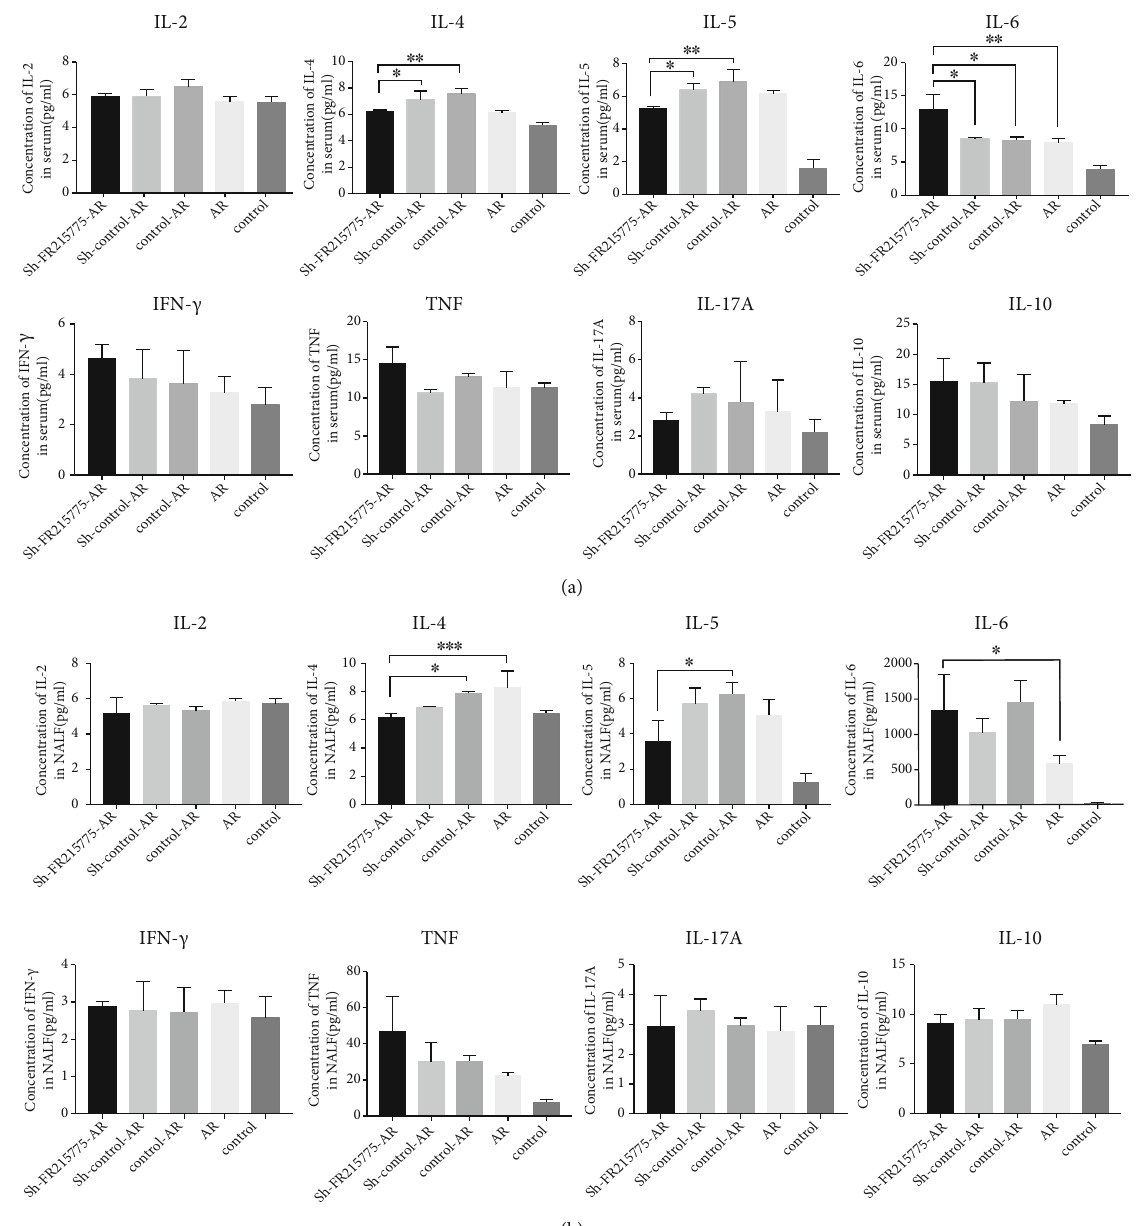
Figure 6: The sh-FR215775-AR group mice showed downregulation of Th2 cytokines. Expression of related cytokines in (a) murine serum and (b) murine NALF. The concentrations of IL-4 and IL-5 in lncRNA FR215775 silencing group were signi fi cantly lower than those in control group. Data represent the mean ± SD ( ∗ P < 0 : 05 , ∗∗ P < 0 : 01 , ∗∗∗ P < 0 : 001